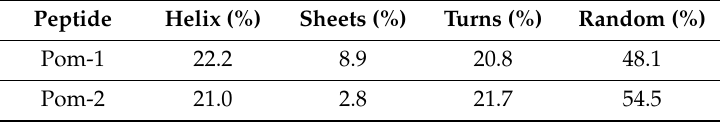
Table 3. Agar diffusion test of Gram-positive and Gram-negative bacterial species against Pomacea poeyana peptides.